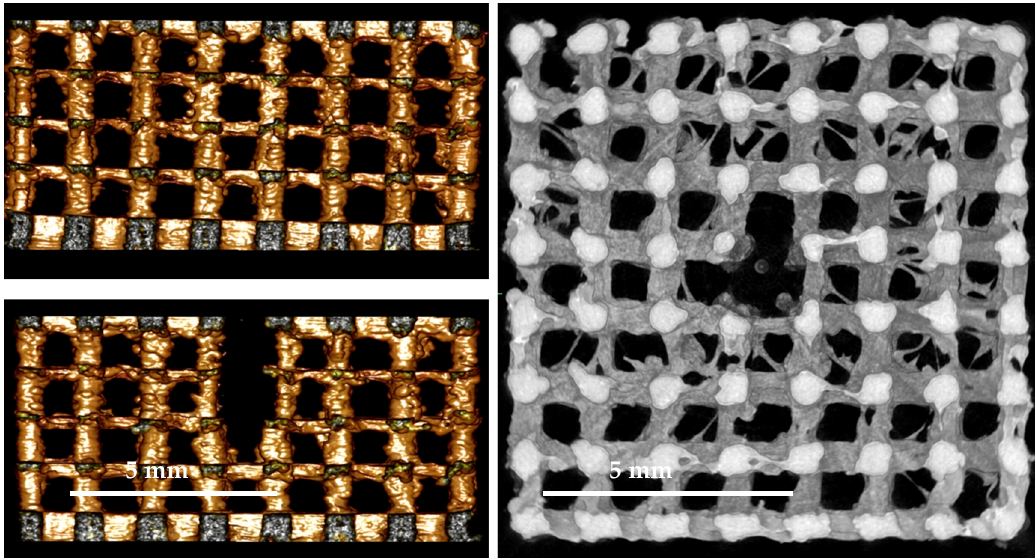
Figure 9. SEM quality control. Magnification: 100×.